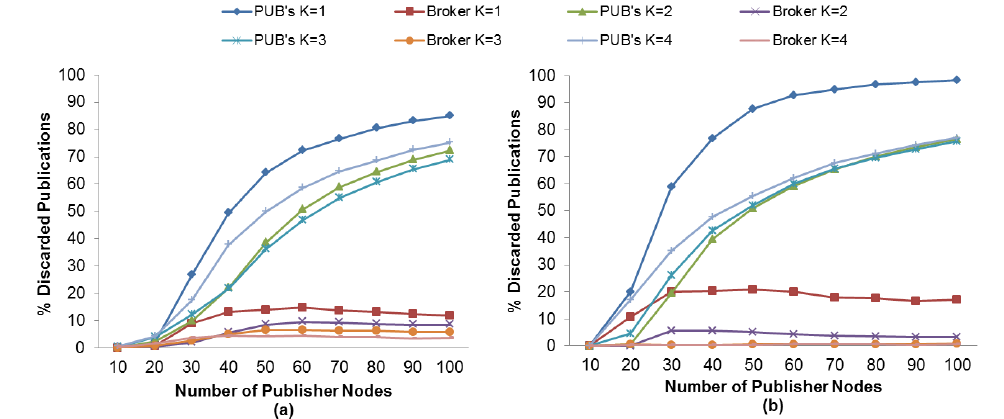
Figure 11. Effect of the number of Publisher nodes on the Dropped Publication Ratio from Broker and Publisher Nodes using different K values without ( a ) and with ( b ) MAC